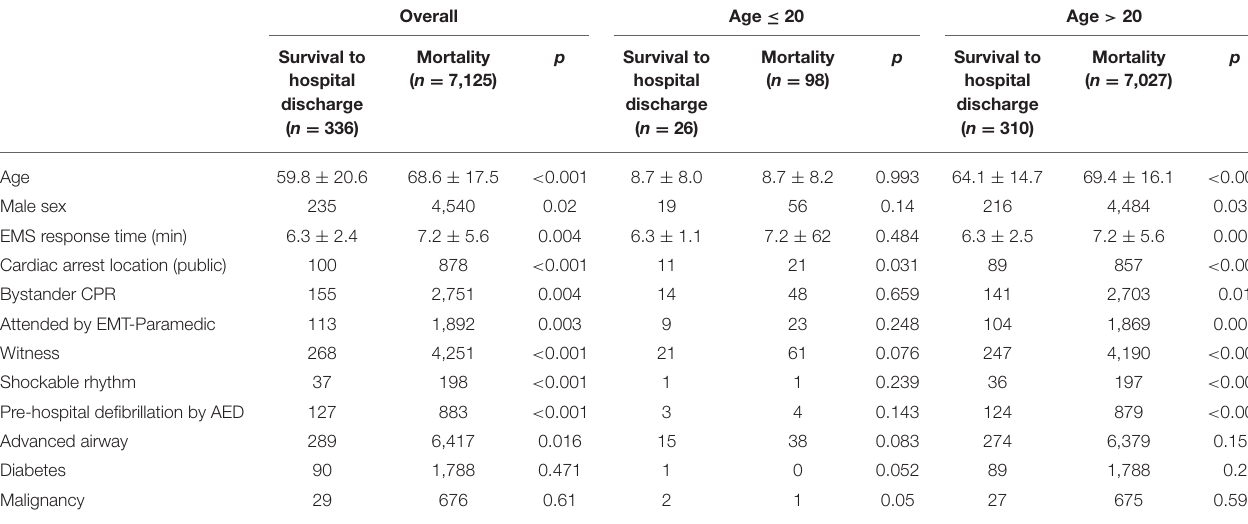
TABLE 2 | Key factors associated with survival till hospital discharge in pediatric and adult out-of-hospital cardiac arrest (OHCA).